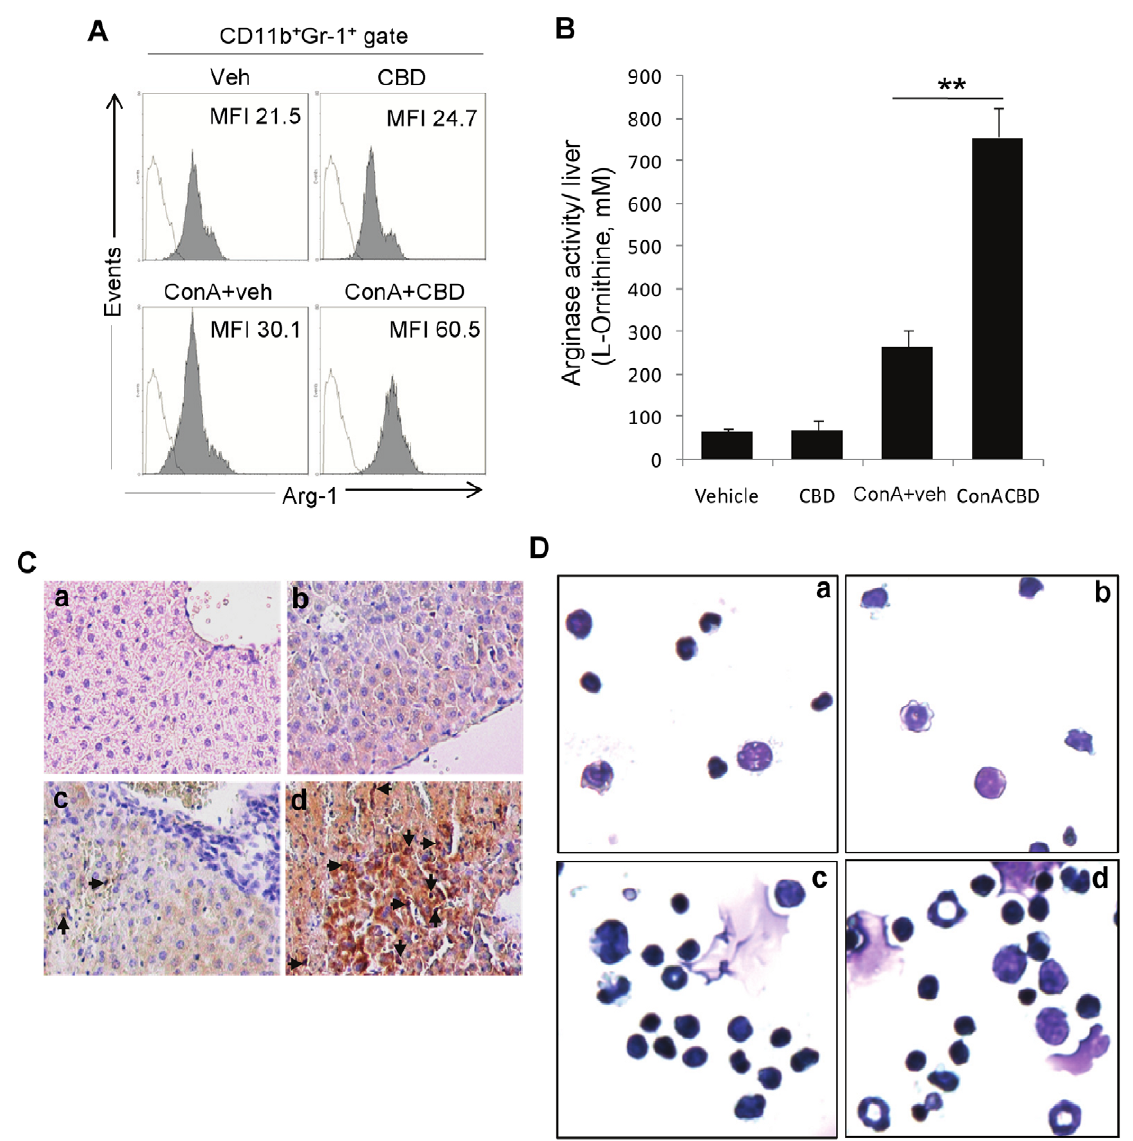
Figure 4. Characterization of MDSCs in liver. Liver infiltrating cells isolated from indicated treatment groups (n=4) were triple-stained for CD11b, Gr-1 and intracellular arginase 1. Respective histograms (filled) for arginase expression on CD11b + Gr-1 + gated cells are shown for each group with respective MFI (A). Open histograms represent staining control. B) Arginase functional activity was determined by spectrophotometric assay using lysates of liver infiltrating cells from each group. Data are mean 6 SEM (n=4). Student’s t -test, **p , 0.01. C) Immunohistochemistry for arginase expression in liver sections and D) Morphology of infiltrating liver cells by Wright Giemsa staining (a. Veh, b. CBD, c. ConA + veh, d. ConA + CBD).